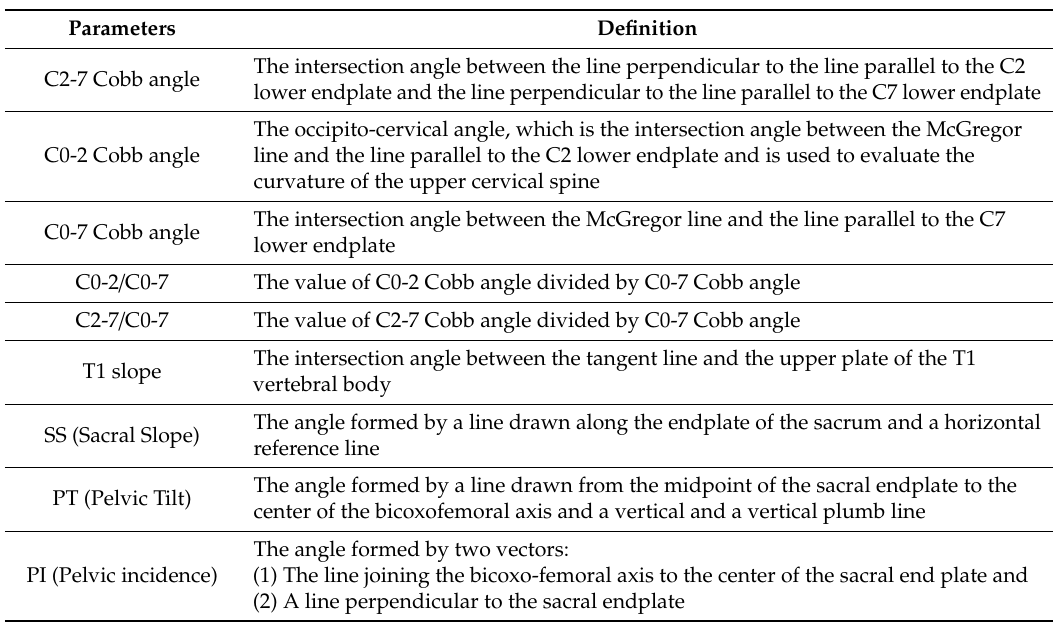
Table 1. Definitions of measurements.